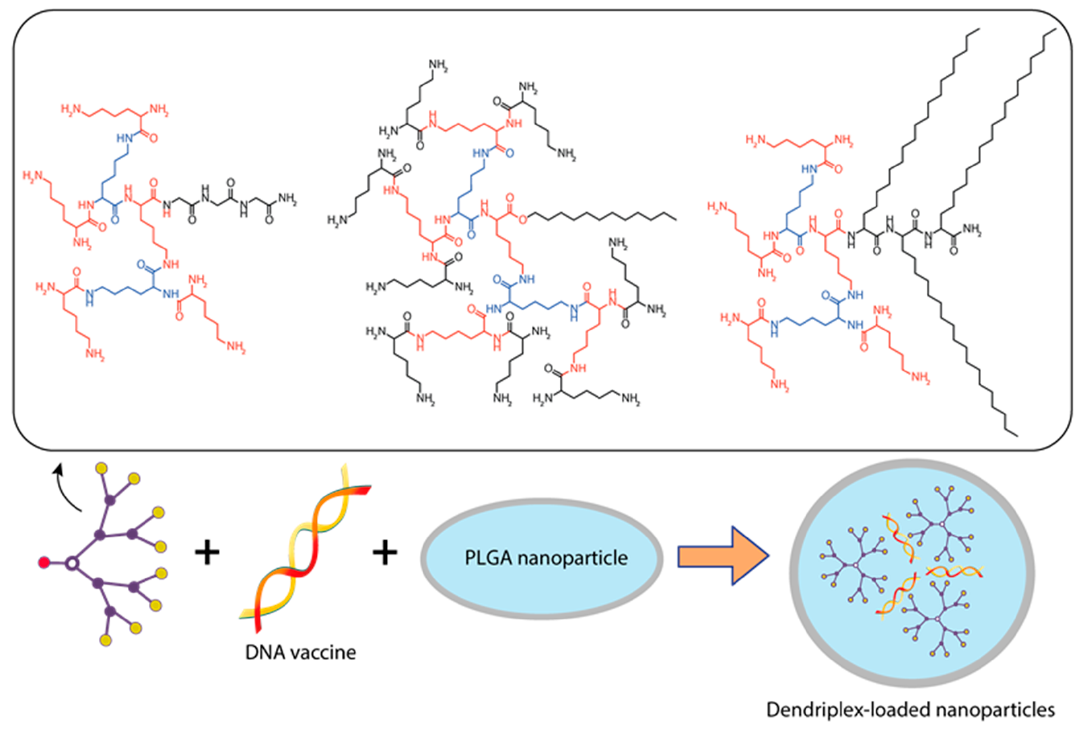
Figure 8. Constructing vaccine nanoformulations based on glycine-polylysine dendrons and their amphiphilic variants.